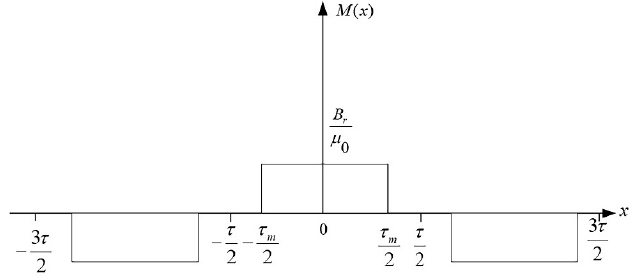
Figure 3. PMLSM magnetic field analysis model ( a ) Permanent magnet magnetic field analysis model ( b ) Magnetic field analysis model of armature windings. The model of the magnet magnetization intensity is shown in Figure 4: